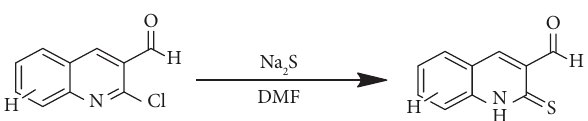
Scheme 1: Substitution reaction on 2-chloro-3-formyl quinoline. minCNCHO HR + DMF, r.t., 5 SN Scheme 2: Synthesis of 3-cyanothiopyrano[2,3- b ]quinoline derivatives.